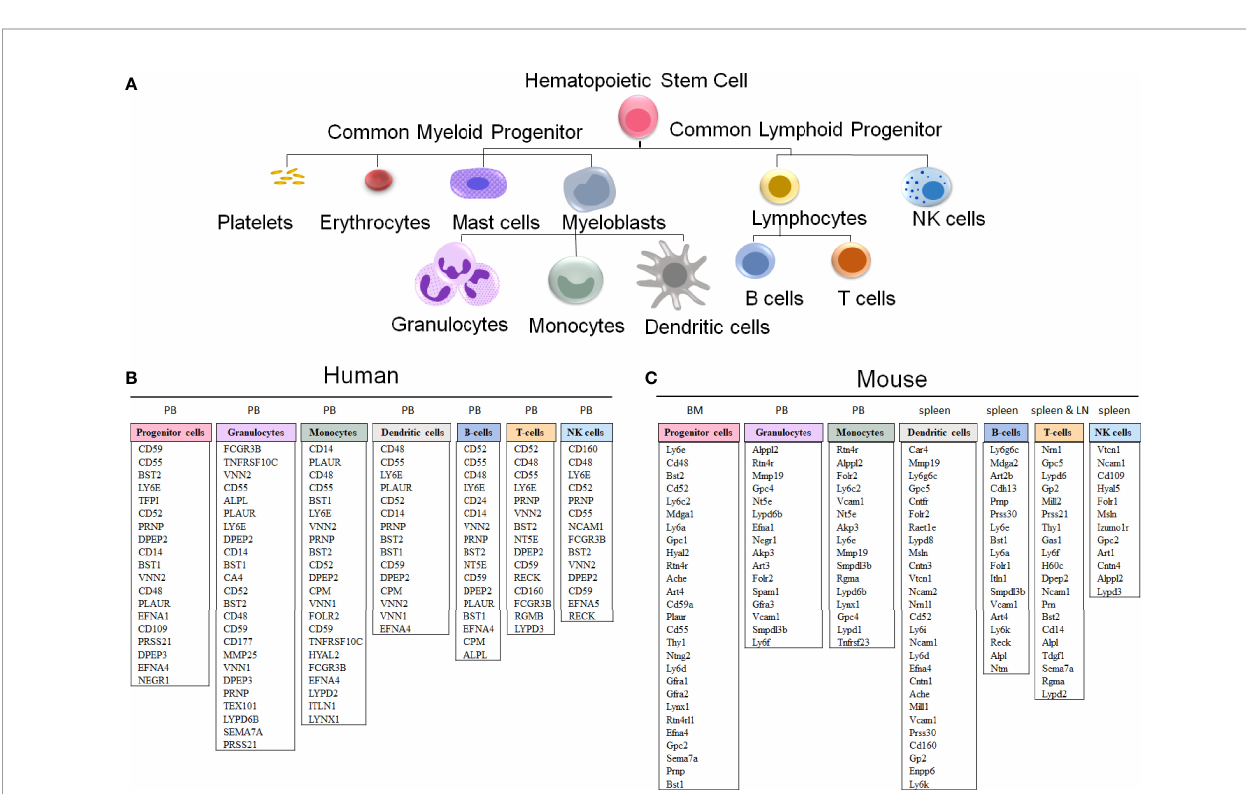
FIGURE 5 | GPI-anchored protein genes in human and mouse hematopoietic cells. (A) A schematic representation of hematopoietic cell differentiation, with the corresponding lists of GPI-AP genes with the highest expression in sorted hematopoietic cell populations in humans (B) and mice (C) . The subsets of the more highly expressed GPI-AP genes, de fi ned as having ≥ 10 transcripts per million (tpm) in published RNA-sequencing datasets, are listed in the descending order of expression within each of the cell lineages. (B) The human GPI-AP gene expression are listed based on RNA-Seq from speci fi ed peripheral blood (PB) subsets by Monaco et al., 2019 (48), available at the Human Blood Atlas. (C) The mouse GPI-AP genes expressed at ≥ 10 tpm are shown based on RNA sequencing expression analysis of mouse (C57BL/6) hematopoietic cell subsets isolated from Bone Marrow (BM, progenitor cells; Bolden et al, 2018 (49)), PB (granulocytes and monocytes), spleen (dendritic cells and T cells published by Marsman et al, 2018 (50); B-cells published by Shi et al, 2015 (51)) and lymph nodes (LN) (T cells published by Marsman et al, 2018 (50))), as extracted from the Haemosphere data portal (52,